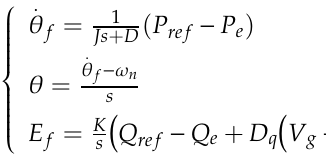
Figure 2. Inverter with virtual synchronous generator (VSG) control structure diagram. Legend: g the frequency of the equivalent internal potential of VSG; ω n , the base frequency of the grid; P ref and Q ref , the set values of active and reactive which are used to control the output power of the inverter; J , the inertia of the virtual synchronous machine; D , the damping coefficient; K , the gain factor of the reactive controller.